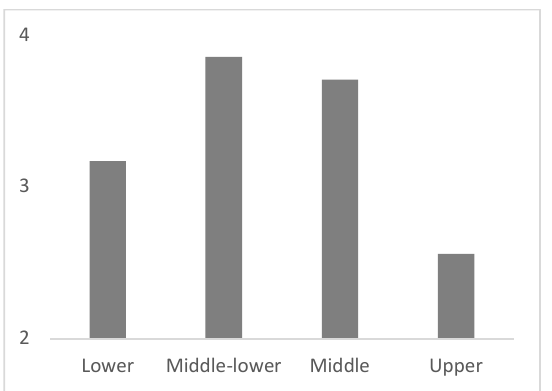
among students have worsened", according to the socio-economic status of students.